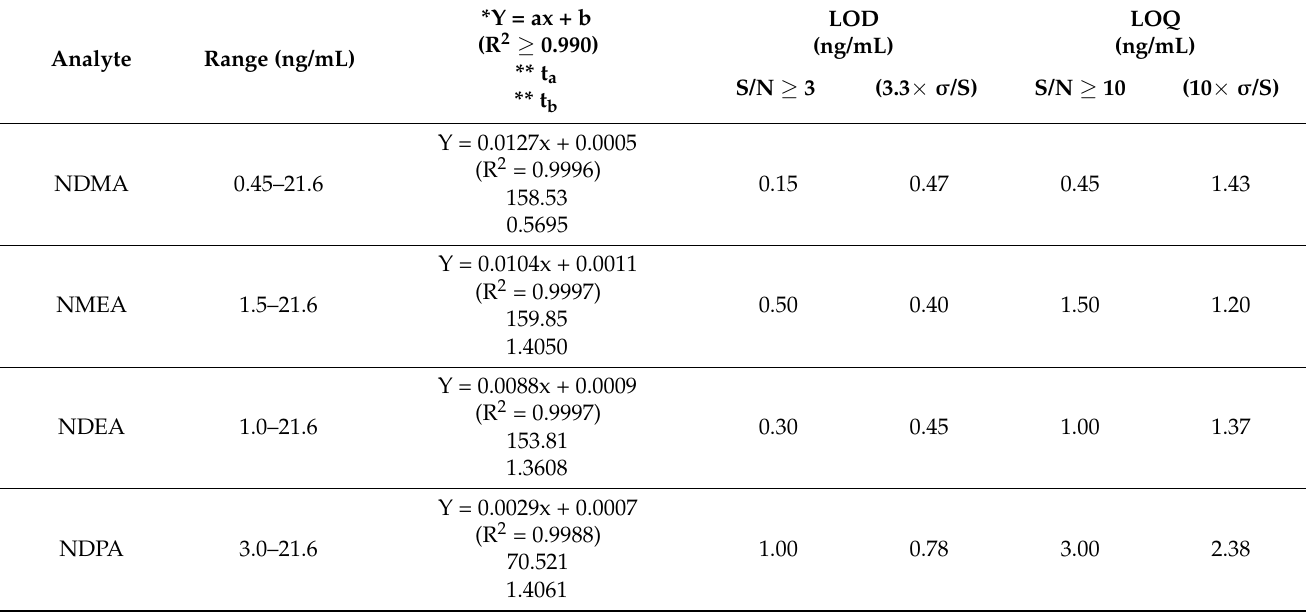
Table 1. Validation results for linearity, LOD, and